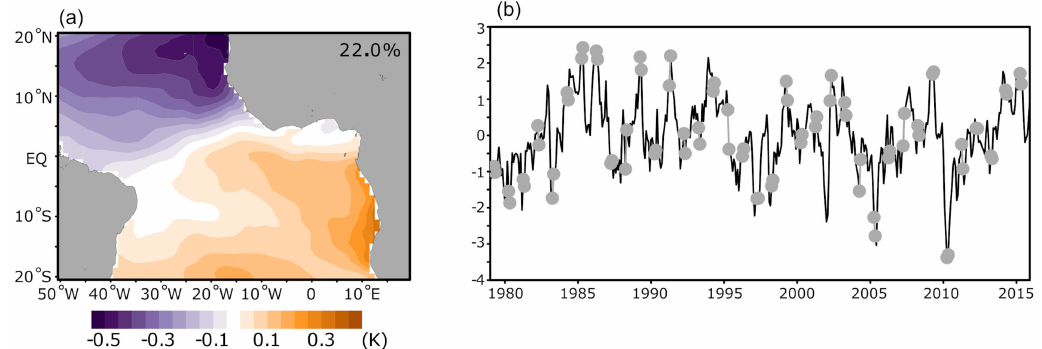
Figure 7. Same as Figure 4, but for EOF 2nd mode ( a ) and gray dots denote the PC score in April and May for each year ( b ).